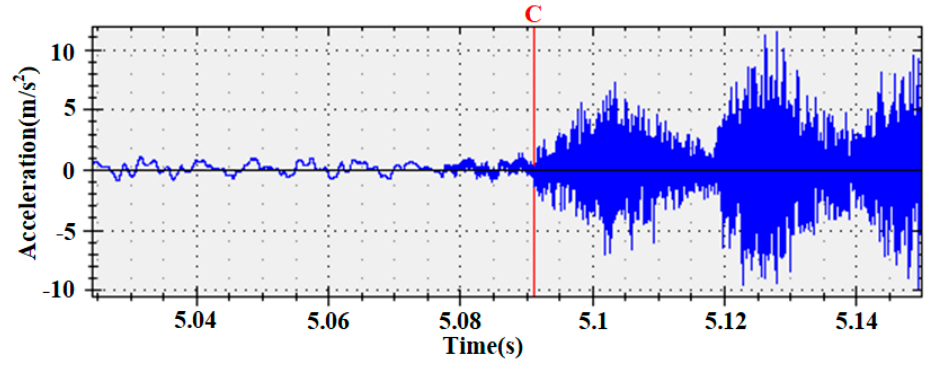
Figure 4. Measured waveform expansion of the vibration signal during the normal action of the on-load tap changer (OLTC).